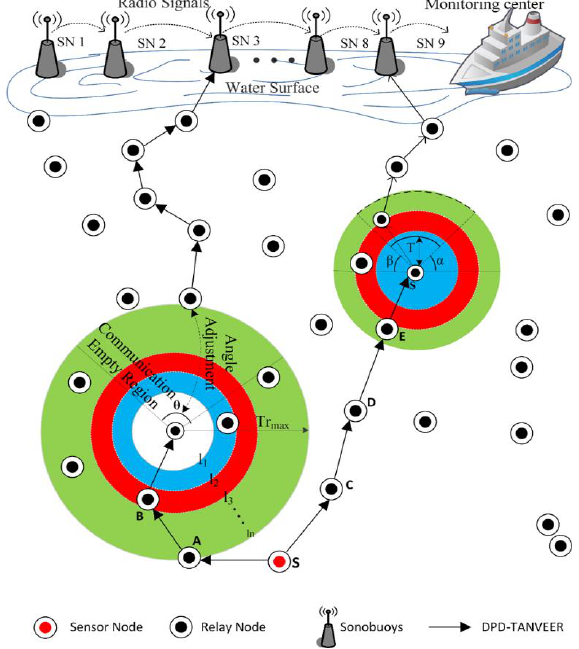
Figure 6. Mechanism of Data Packet Delivery (DPD)-TANVEER.